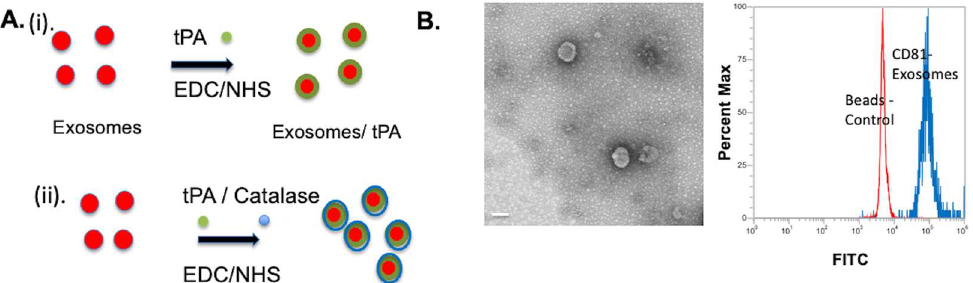
Figure 1. ( A ) Schematic of the exosomes’ formulation. Exosomes were first treated with EDC/NHS and subsequently reacted with tPA and/or catalase. (i). Exosomes conjugation with tPA, and (ii) Exosomes conjugation with tPA/catalase. ( B ) TEM image of the exosome and flow cytometry characterization of exosome marker CD81. Scale bar 100 nm. Table 1. DLS measurement.